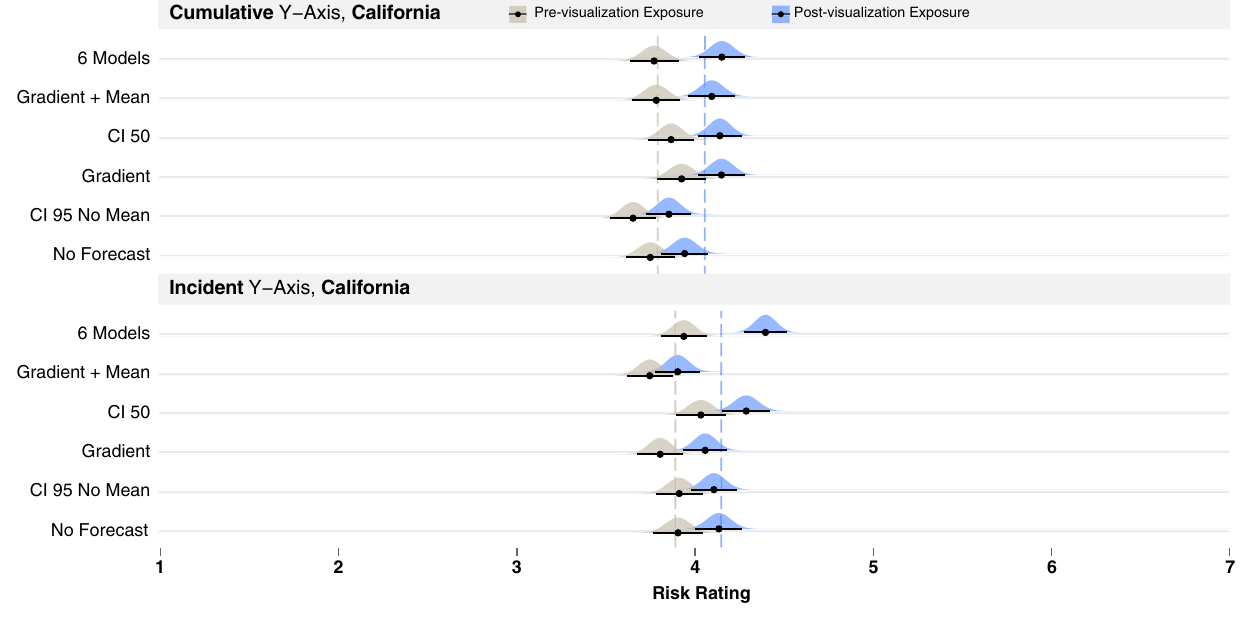
Figure 6. Results of the visualization comparison in Experiment 2 (ordered by size of the time point main effect), where pre-visualization risk judgments are colored gray and post-visualization judgments blue, for cumulative y-axis (top) and incident y-axis (bottom). Dashed lines show the mean pre- and post-visualization risk judgments for each y-axis group as a whole. Black bars show 95% confidence intervals around the mean (black dot) for each condition using the Cousineau–Morey method 44 and the density plots were generated from this